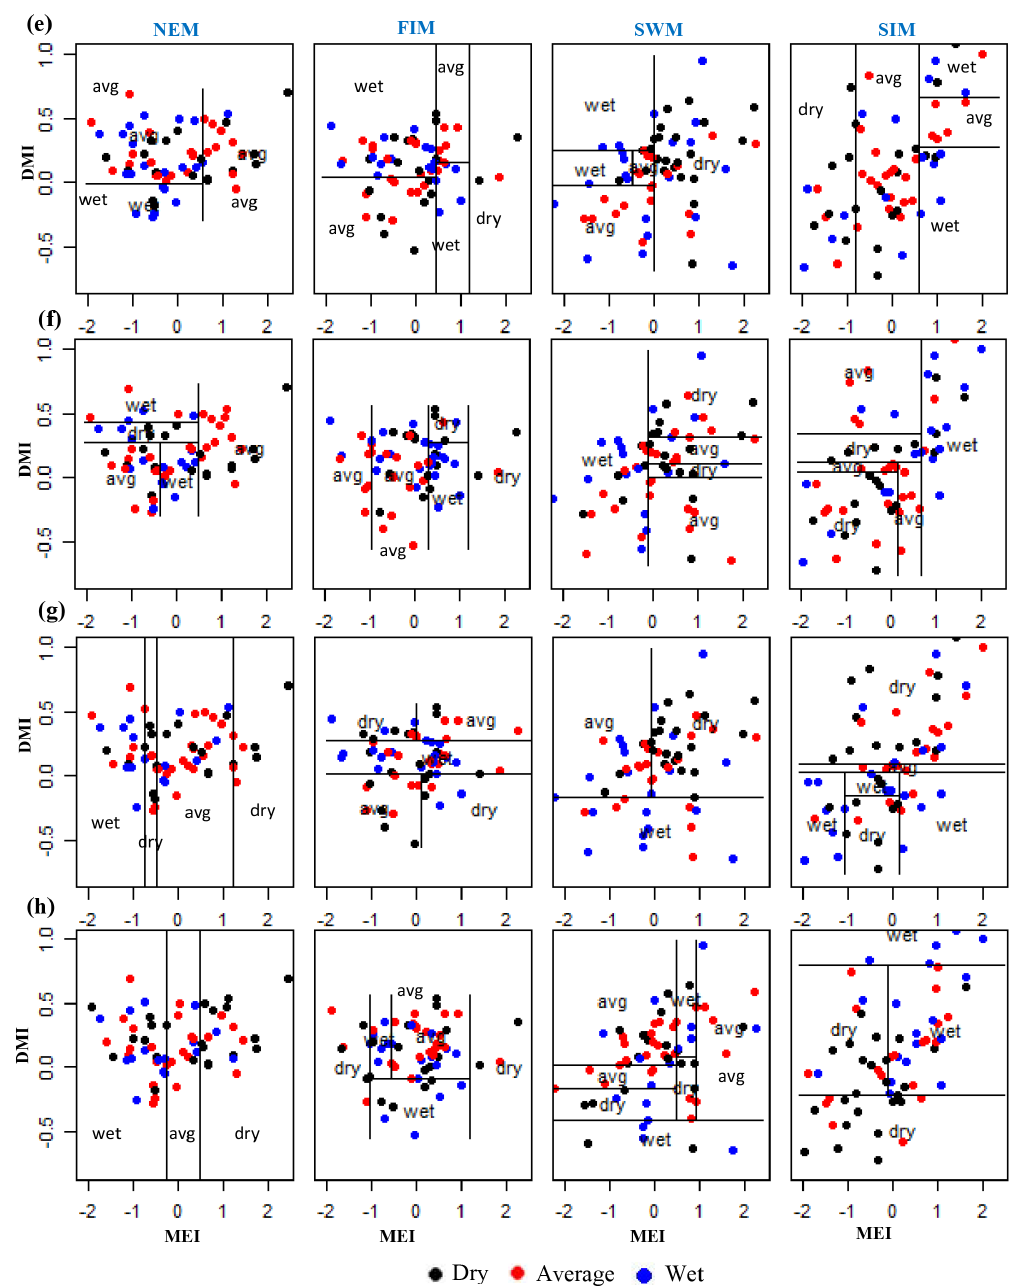
Figure A5. Identifying relationships between three rainfall classes (dry, average, wet) and MEI and DMI values using classification tree models. (a) Laxapana, (b) Norwood, (c) Norton Bridge, and (d)